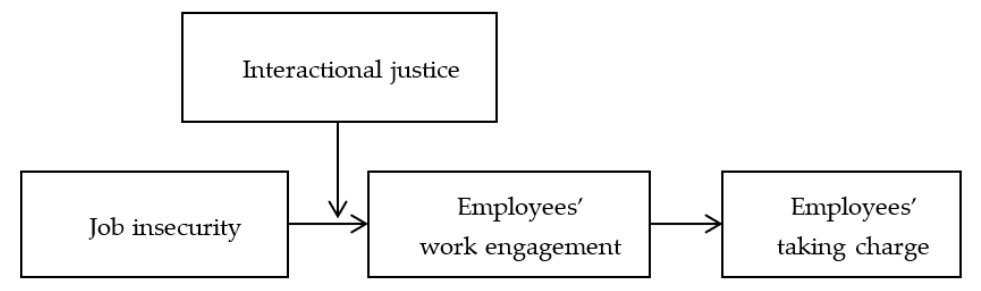
Figure 1. Overall research model.